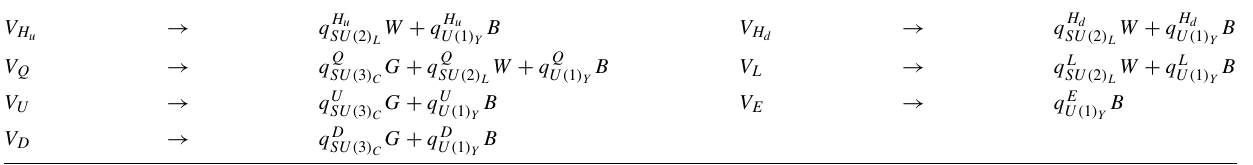
Table 20 Vector superfields corresponding to each of the given chiral superfields expressed as a linear combination of the vector superfields corresponding to the gauge groups of the model weighted by the appro-